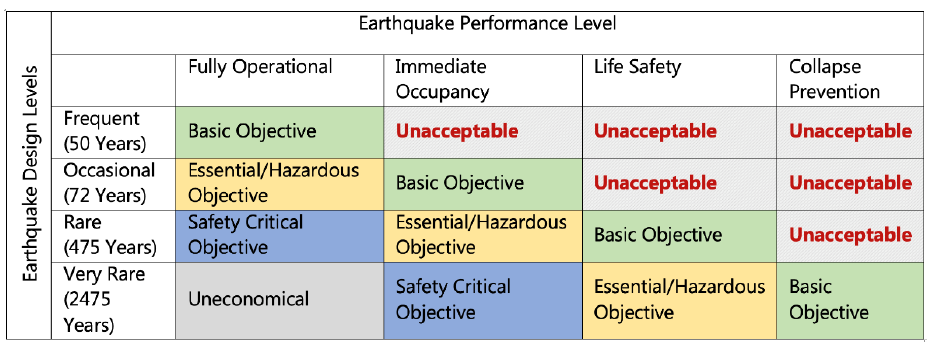
Figure 10. Framework proposed by SEAOC for performance-based seismic design (PBSD) [7].